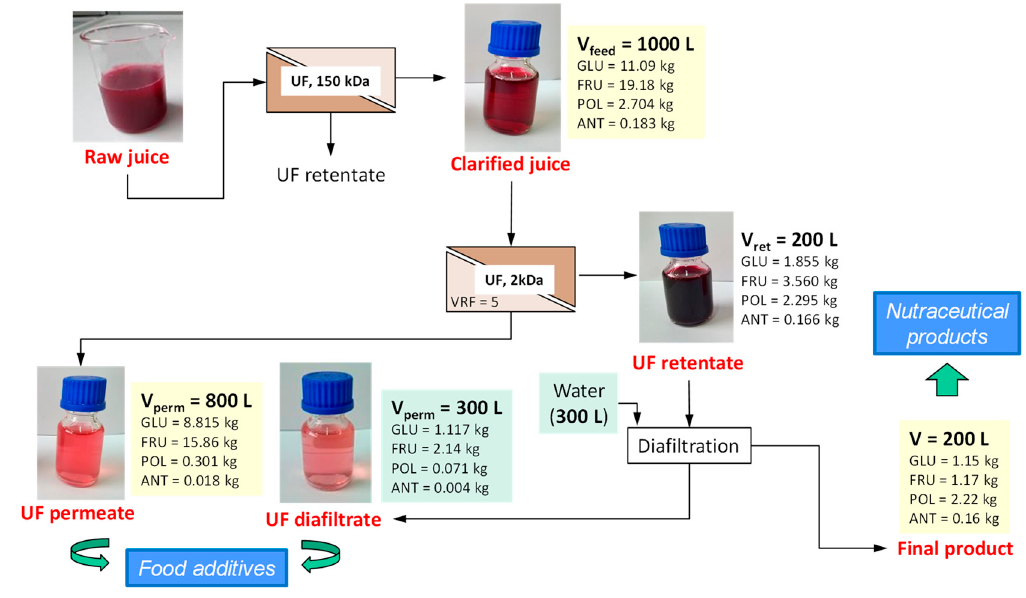
Figure 3. Mass balance of the fractionation process of the pomegranate clarified juice with Desal GK membrane (GLU, glucose; FRU, fructose; POL, polyphenols; ANT, anthocyanins) [68].